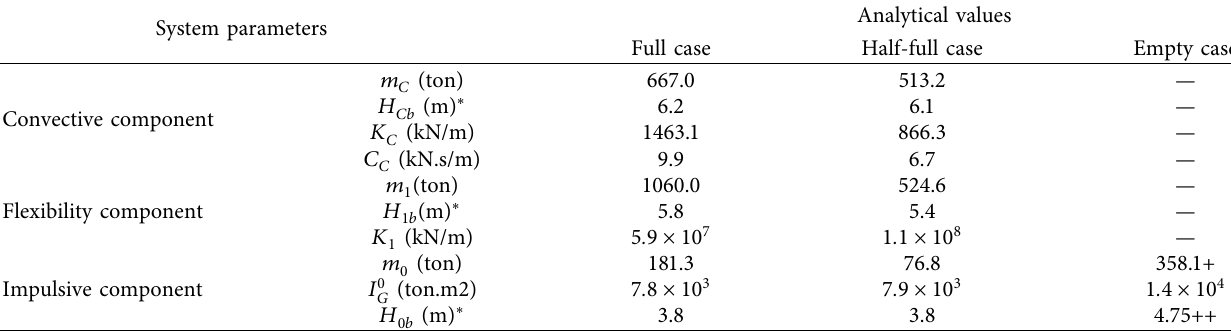
Table 1: The characteristics of the equivalent simplified liquid-tank system calculated for the sample structures with various filling levels. System